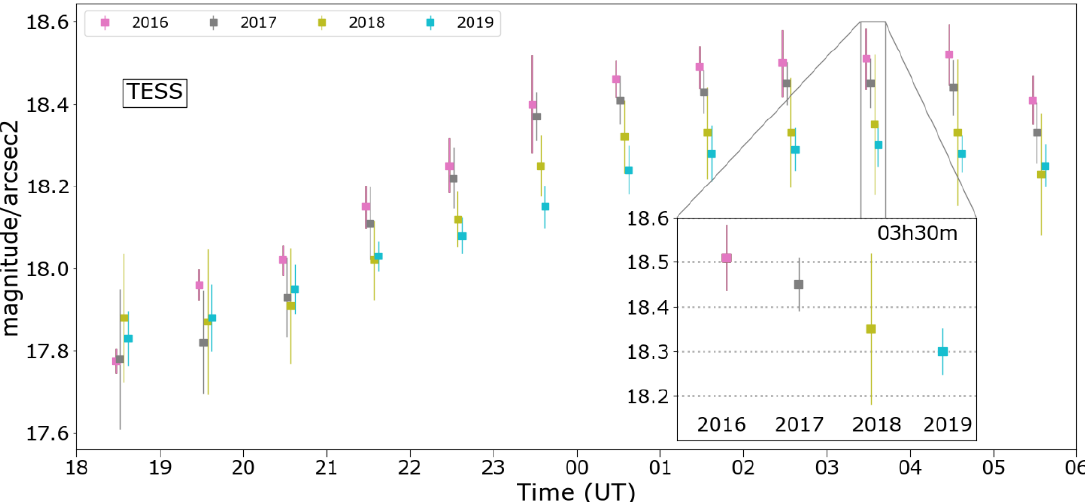
Figure 20. Change in position and shape of the curves showing the evolution of TESS-W magnitude throughout the night in winter. Data were grouped by year and binned in hourly intervals. Table 4. Binned Winter Evolution in Johnson V (mag/arcsec 2 ).